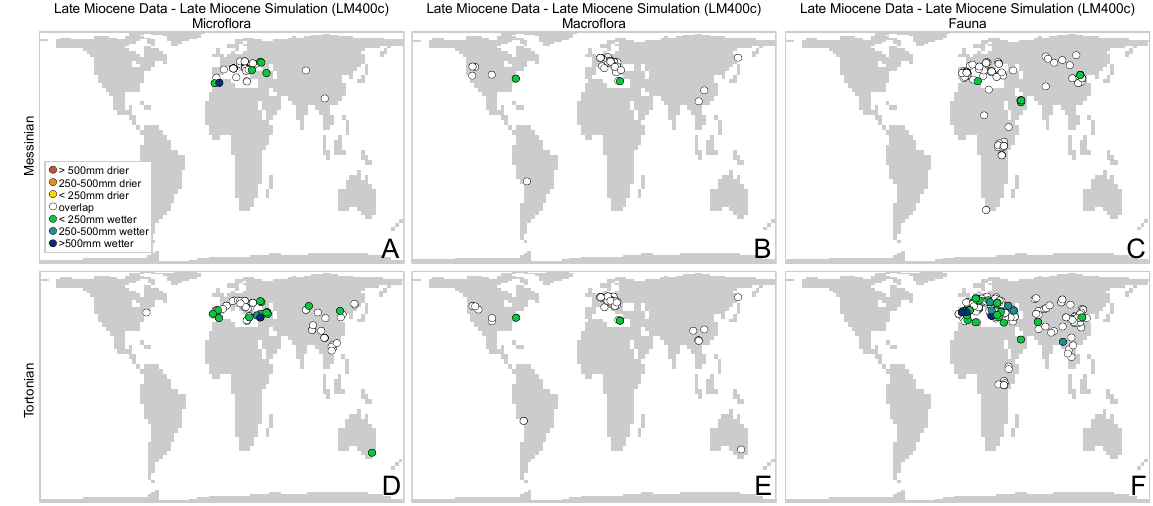
Fig. 13. Results from the model–data comparison for mean annual precipitation, late Miocene